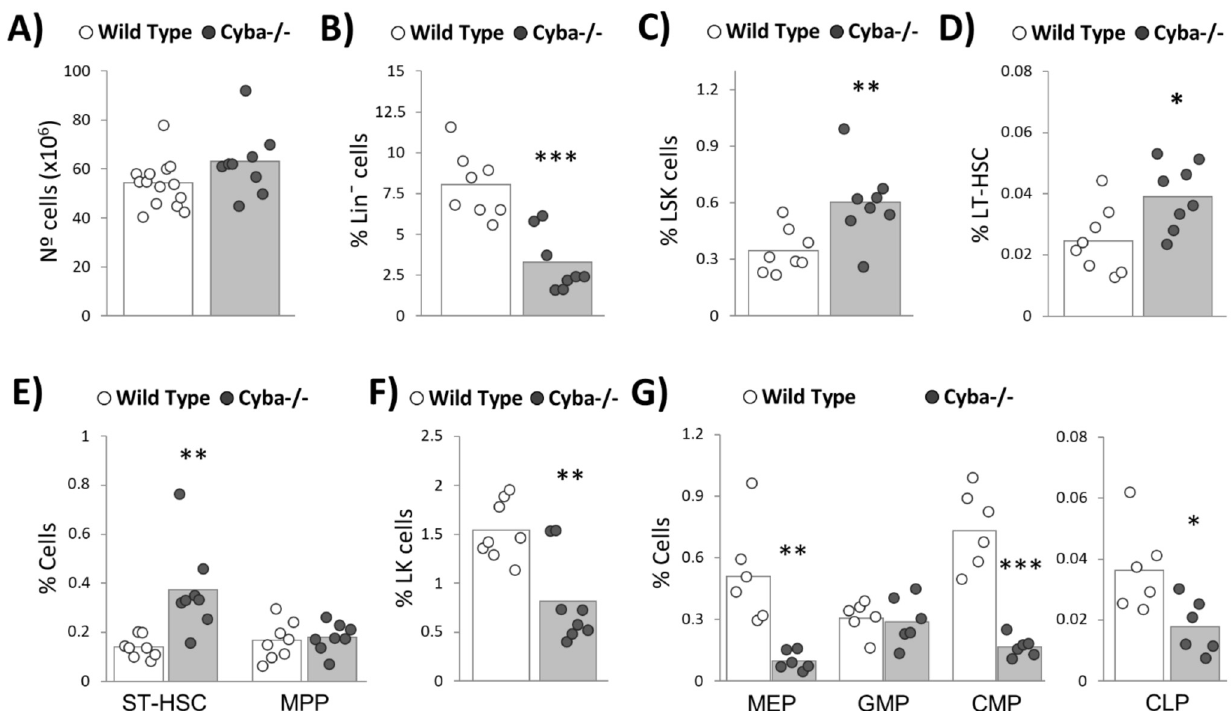
Figure 4. Granuloma-bearing Cyba − / − mice show a reduction in haematopoietic progenitors. ( A ) Total number of bone marrow (BM) cells in Cyba − / − and control mice after red blood cell (RBC) lysis. ( B , C ) Percentage of Lin − and Lin − Sca-1 + c- Kit + (LSK) cells in the BM of Cyba − / − and control mice, respectively. ( D , E ) Analysis of subpopulations of haematopoietic stem cells (HSCs) in the BM of Cyba − / − and control mice. LT-HSC: long-term HSC (LSK CD34 − Flt3 − ). ST-HSC: short-term HSC (LSK CD34 + Flt3 − ). MPP: multipotent progenitors (LSK CD34 + Flt3 + ). ( F ) Percentage of Lin − Sca-1 − c-Kit + (LK) cells in the BM of Cyba − / − and control mice. ( G ) Analysis of subpopulations of haematopoietic progenitor cells (HPCs) in the BM of Cyba − / − and control mice. MEP: megakaryocyte-erythrocyte progenitors (LK CD34 − CD16/32 − ). GMP: granulocyte– monocyte progenitors (LK CD34 + CD16/32 + ). CMP: common myeloid progenitors (LK CD34 + CD16/32 − ). CLP: common lymphoid progenitors (Lin − Sca-1 low c-Kit low IL-7R α + ). * p < 0.05, ** p < 0.01, *** p <